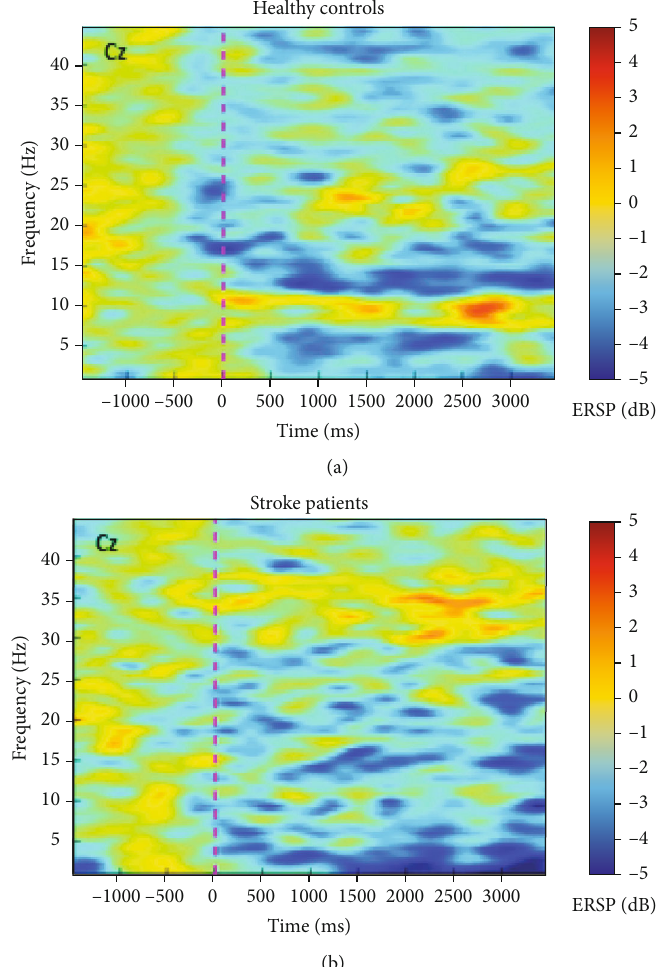
Figure 3: Group-averaged time-frequency plots for the motor area (central electrode, Cz), with bimanual thumb opposition task. (a) shows the time-frequency for healthy controls, while in (b), we present data from the stroke patients ’